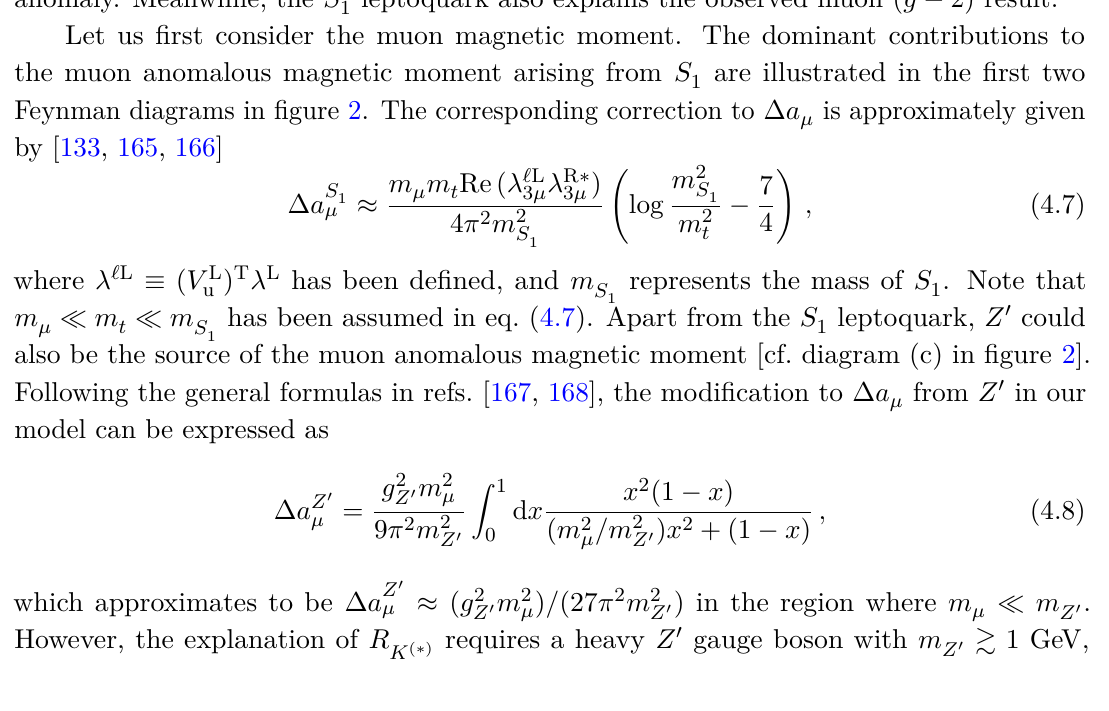
Figure 2 . The Feynman diagrams for the dominant contributions from S anomalous magnetic